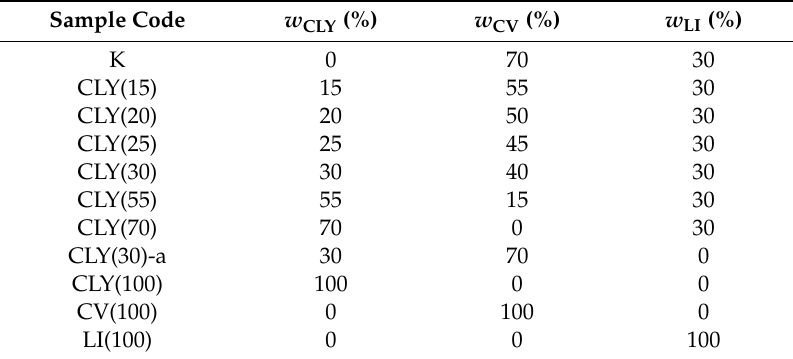
Table 1. Sample codes and blend